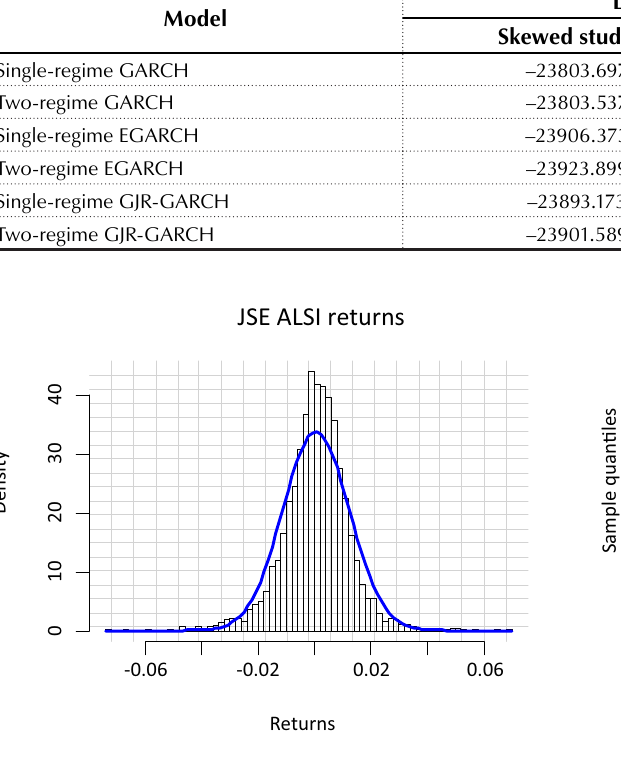
Figure 3. Histogram and the Q-Q plots of the returns